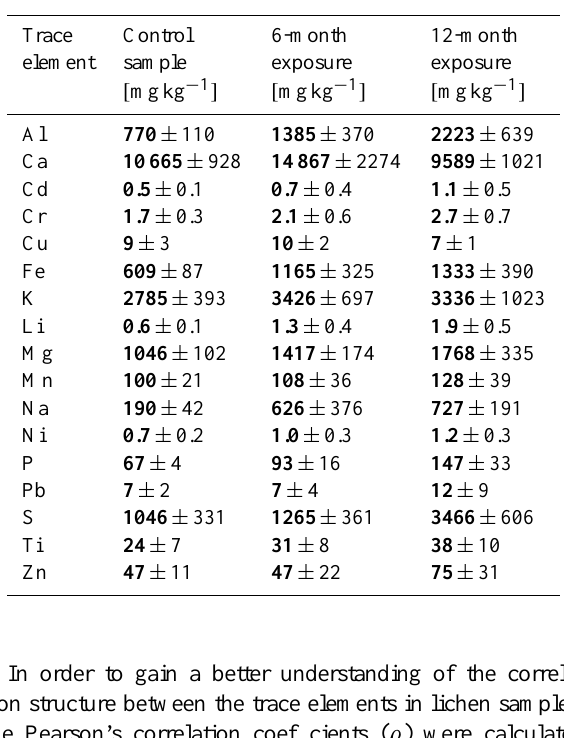
Table 3. Mean value ± standard deviation ( m ± SD) of the trace el- ement concentrations measured in the control sample and in lichen bags after 6- and 12-month exposures. The mean values of the trace element concentrations are highlighted in